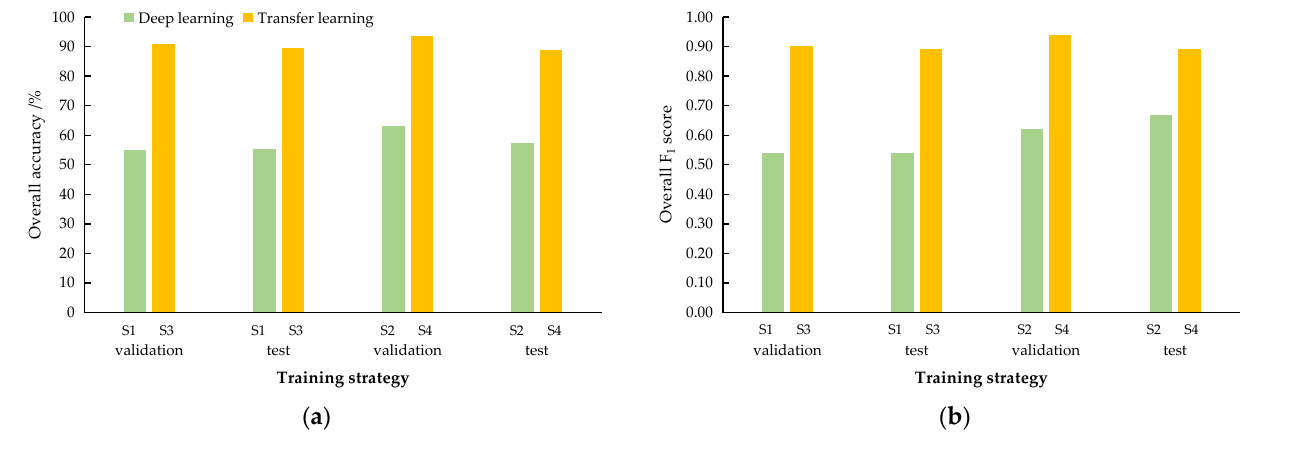
Figure 7. Assessment metric comparison of different training strategies. ( a ) Overall accuracy; ( b ) Overall F 1 score. S1 denotes the training strategy from scratch and with the initial 10 layers frozen; S2 denotes the training strategy from scratch and with no frozen layer; S3 denotes the training strategy of the pretrained network and with the initial 10 layers frozen; S4 denotes the training strategy of the pretrained network and no frozen layer.